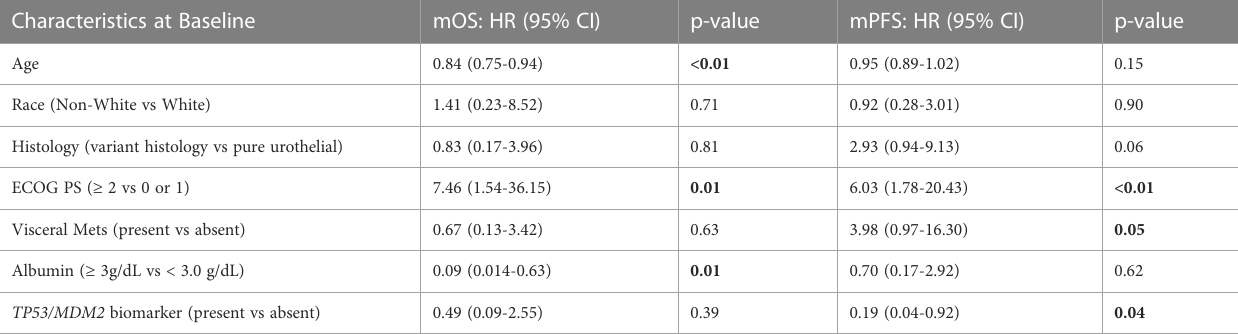
TABLE 4 Multivariable analysis of overall survival and progression free- survival with relevant clinical variables and composite TP53/MDM2 biomarker. Characteristics at